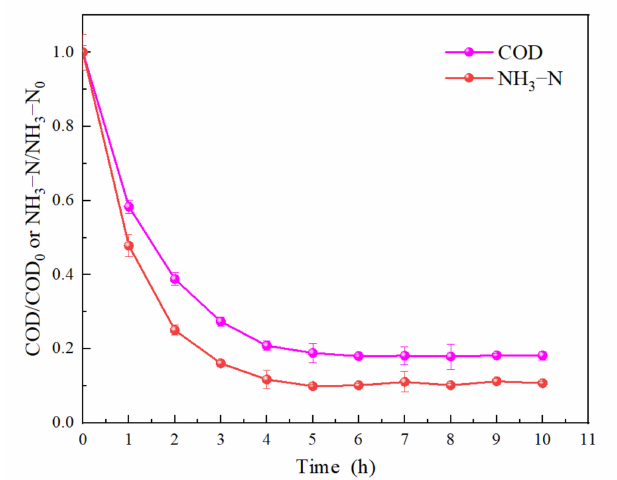
Figure 6. Variation of COD and NH 3 -N removal rate with reaction time. (Initial pH: 3.0; PS/12COD ratio: 1; ZVI dosage: 1.5 g/L; current density: 62.5 mA/cm 2 ; reaction time: 6